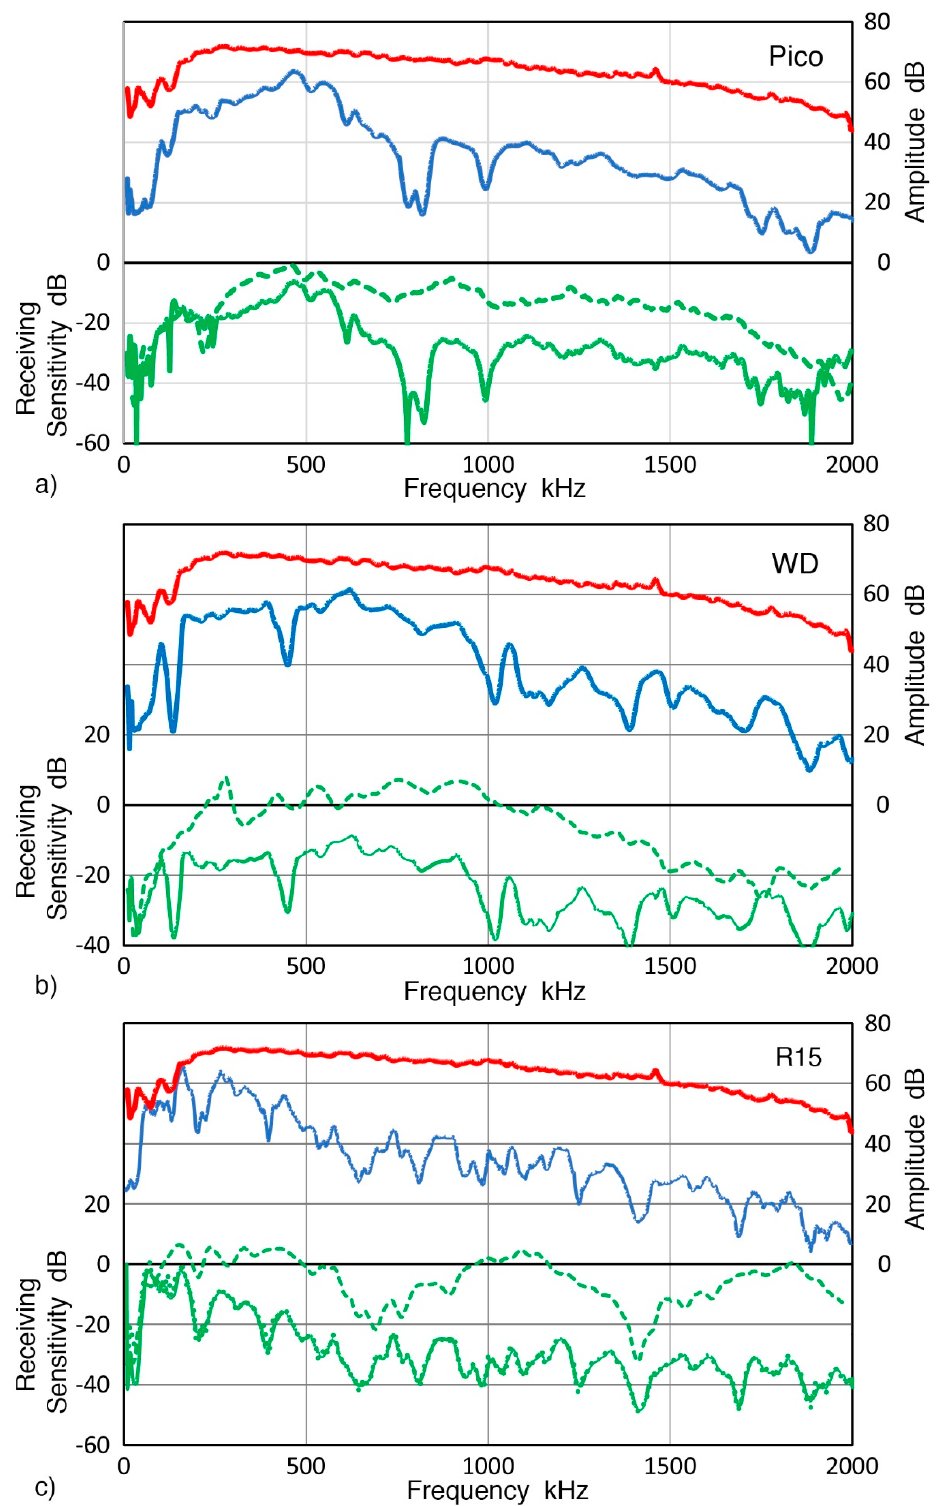
Figure 11. RW receiving sensitivity of three common AE sensors. Top red curve (right scale): averaged displacement spectrum from Figure 8b (0 dB in reference to 1 nm displacement); blue curve (right scale): sensor output spectrum in dB (0 dB in reference to 1 V sensor output); bottom green curve (left scale): RW receiving sensitivity with 0 dB in reference to 1 V / nm; green dash curve (left scale): NW receiving sensitivity for the same sensor. ( a ) Pico sensor, ( b ) WD sensor, and ( c ) R15 sensor. Green dot curve in Figure 11cgives RW receiving sensitivity using 5-ms long